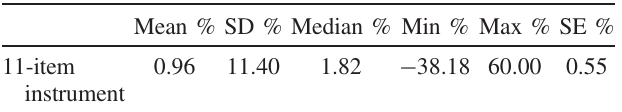
TABLE XIV. Descriptive statistics for % shifts between pre- and postresponses to proposed 11-item instrument.